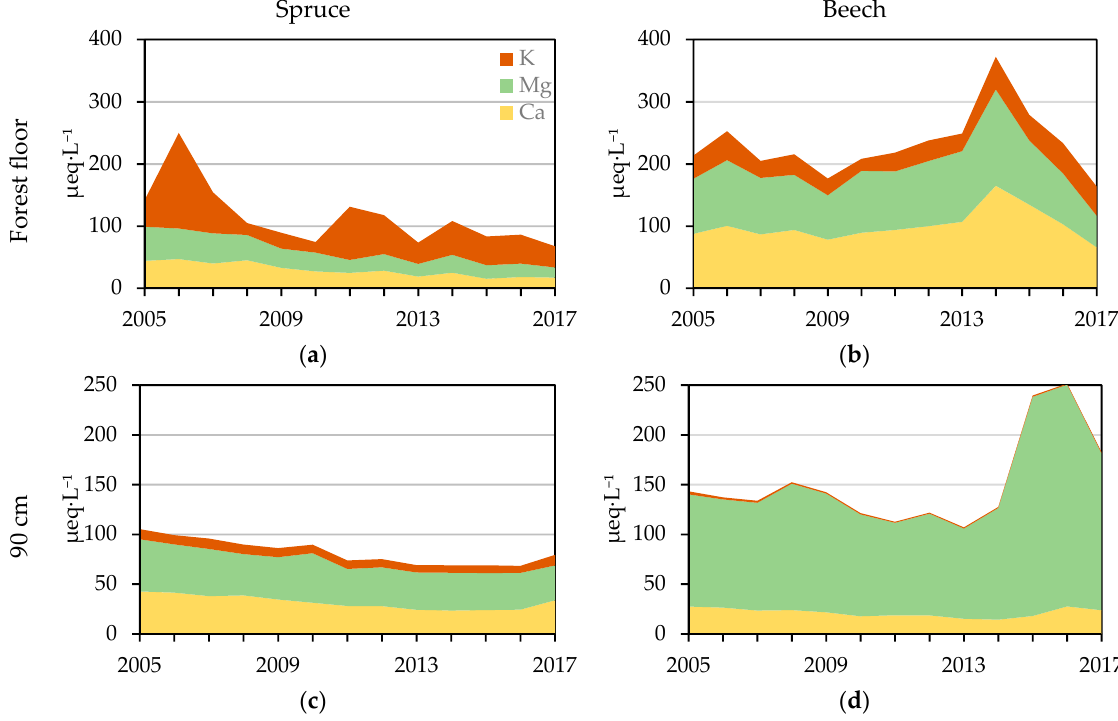
Figure 6. Mean annual BC (K + +Mg 2+ +Ca 2+ ) concentrations in forest floor ( a , b ) and 90 cm ( c , d ) soil solution in spruce (left) and beech (right)